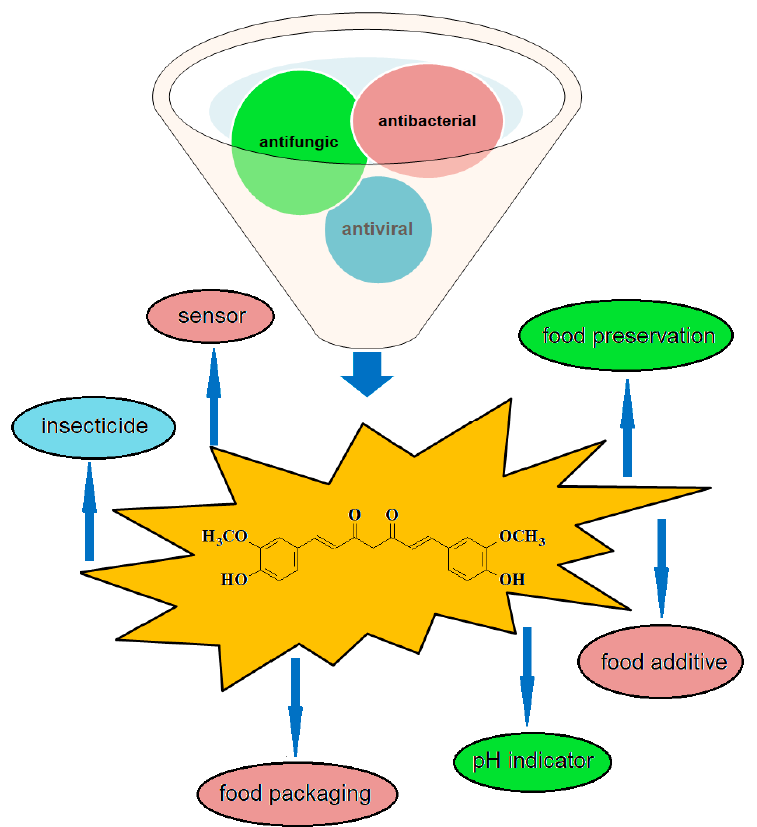
Figure 5. Applications of curcumin in food, due to its antiviral, antibacterial, and antifungal properties.